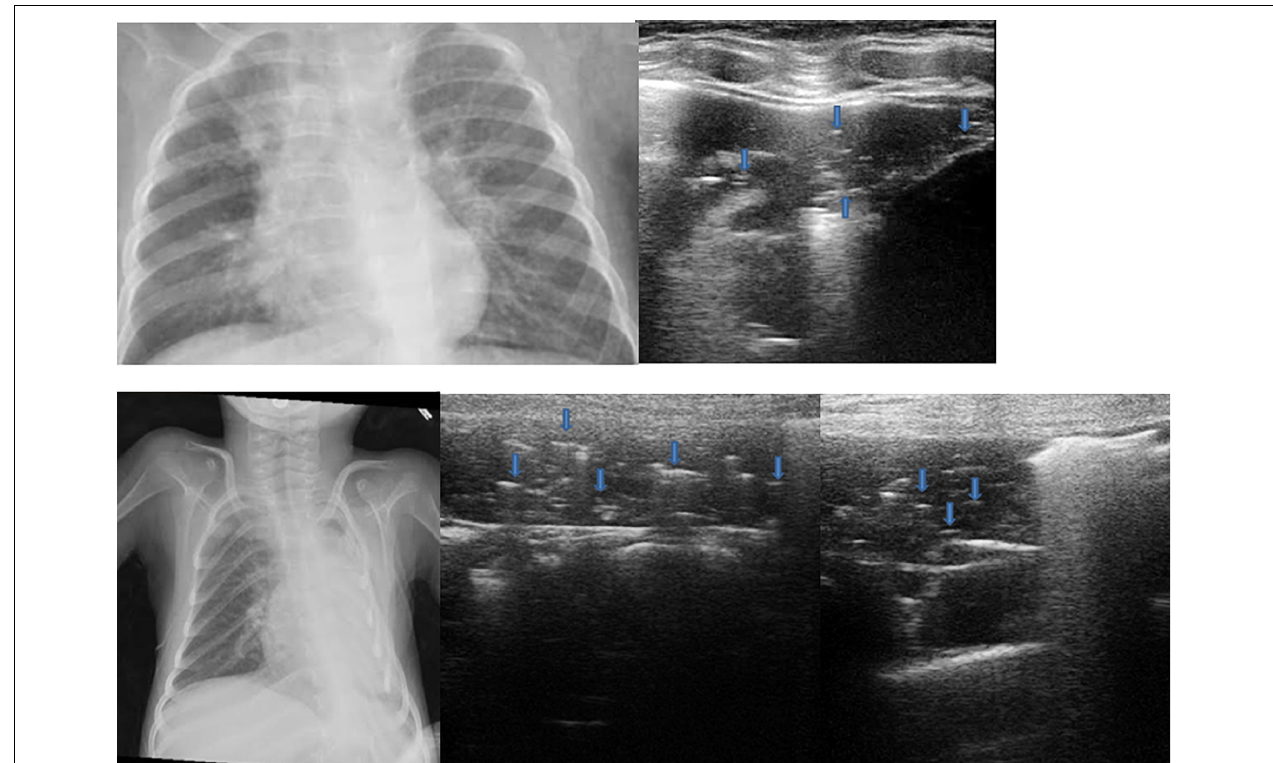
FIGURE 7 | The upper part of the figure shows chest X-ray and lung ultrasound images of a 7-year-old girl with uncontrolled asthma and an ongoing severe asthma attack, with no clinical or laboratory signs of infections. The chest X-ray shows non-specific areas of reduced transparency in the right apical and right basal sites. Grayscale lung ultrasound examination (transverse scan between intercostal fields; linear probe with 12 MHz frequency) shows – on the right paracardiac area – subpleural consolidation with hyperechoic images of air bubbles (static aerial bronchograms, arrows ) that do not move inward during breathing and are parallel to each other. Their presence is associated with the identification of atelectasis, supported by the clinical and laboratory context of the patient being examined. The lower part of the figure shows chest X-ray and lung ultrasound images of a 4-year-old girl with neuromuscular pathology in nocturnal non-invasive ventilation with ongoing respiratory exacerbation without laboratory and clinical signs of infections. The chest X-ray shows a completely white left lung not well definable. Grayscale lung ultrasound examination (transverse scan between intercostal fields; linear probe with 12 MHz frequency) shows the entire left lung’s subpleural consolidations with hyperechoic images of air bubbles (static aerial bronchograms, arrows ) static and parallel to each other. Their presence is associated with the identification of left pulmonary atelectasis. The ultrasound suspicion is supported by the clinical and laboratory context of the patient being